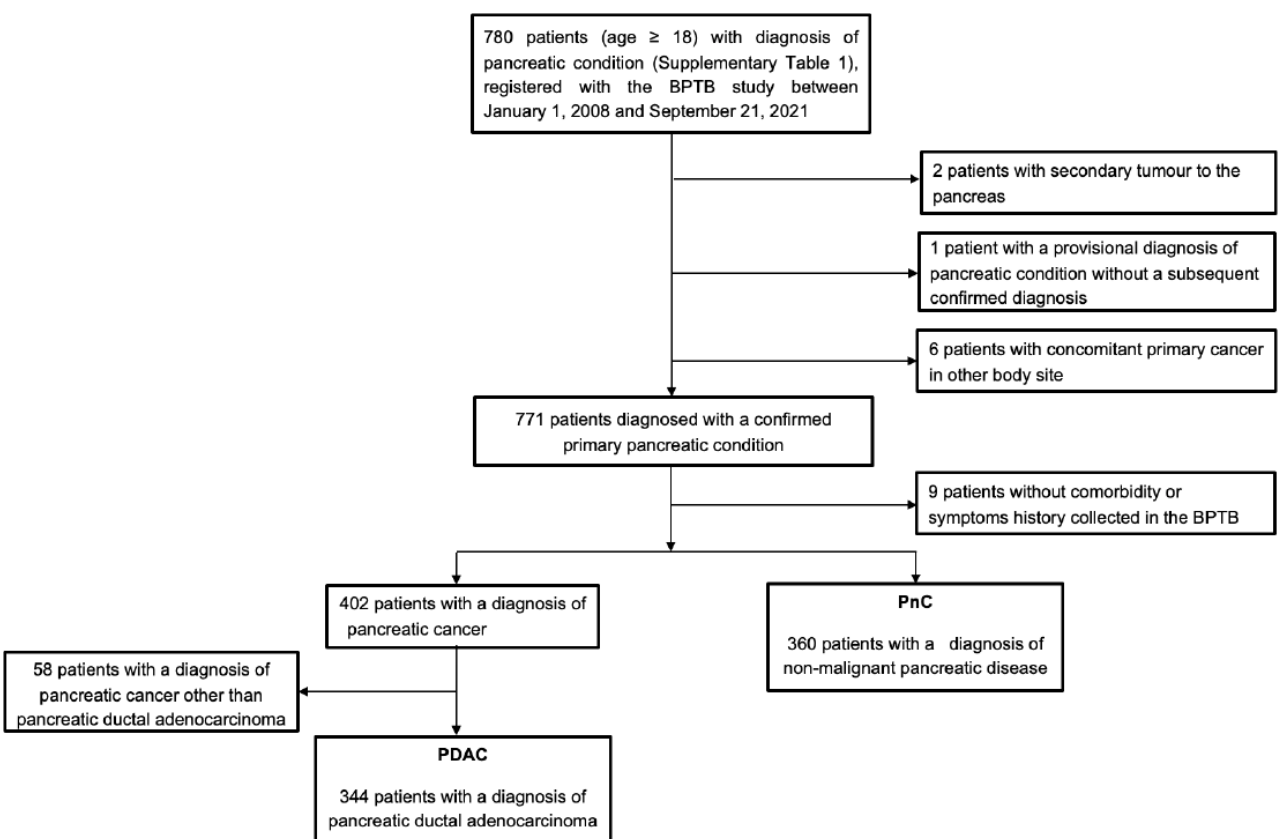
Figure 1. CONSORT diagram for selection of patients in the case ‐ control study.